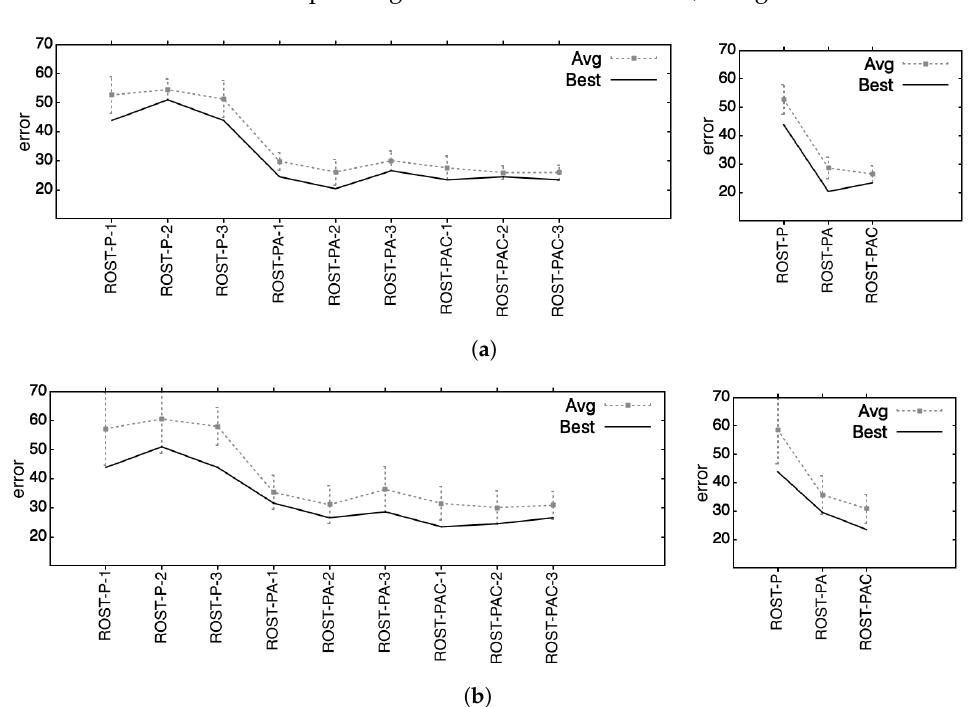
Figure 2. Results on the best solutions obtained on the considered datasets. The percentage of incorrectly classified data is plotted. Best stands for the best solution, Avg stands for Average and the Standard Deviation is represented by error bars. ( a ) Best , Average and Standard Deviation are computed on the values from Table 16; ( b ) Best , Average , and Standard Deviation are computed on the values given in Table